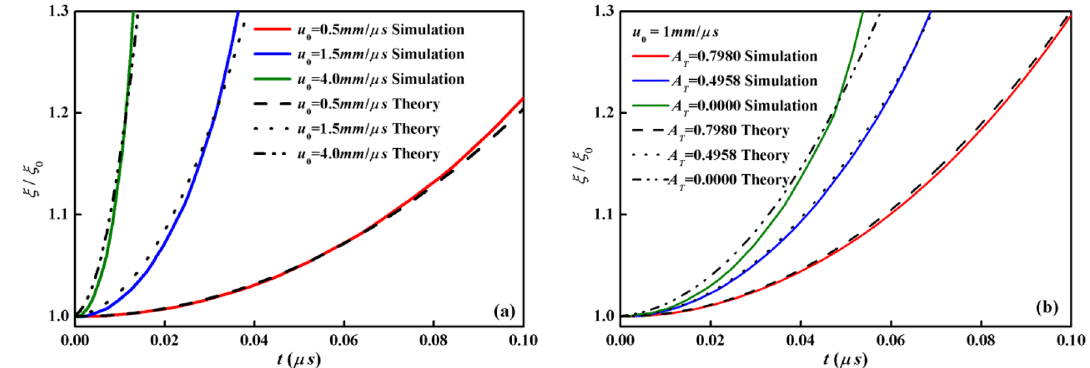
Figure 3. Growth factors versus time by numerical simulations and classical theory of KHI between two ideal fluids: ( a ) u 0 = 0.5, 1.5, 4.0 mm/μs as A T = 0, ( b ) A T = 0.7980, 0.4958, 0.0 as u 0 = 1.0